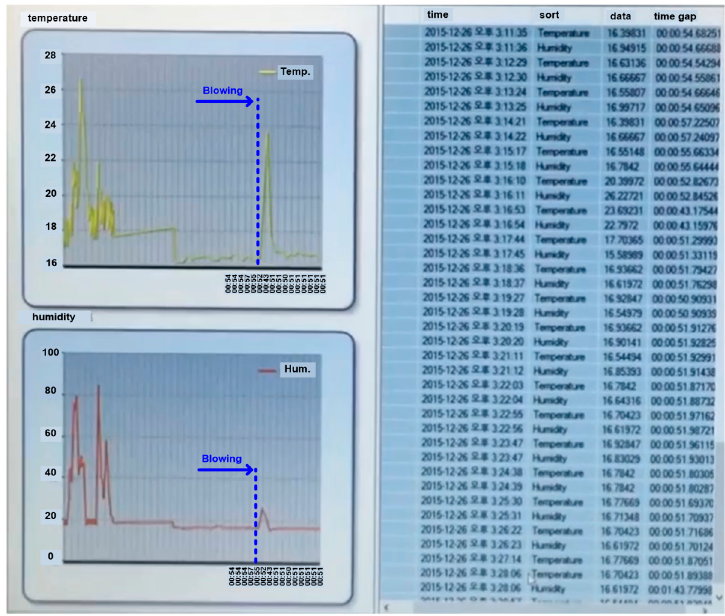
Figure 16. The temperature and humidity graph and data measured by the wireless sensor node system.